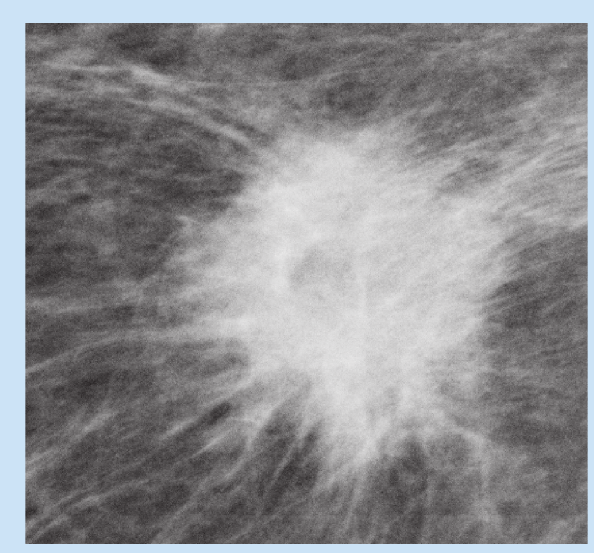
Fig. 3. Patient 3 – heterogeneous calcifications (with spiculated mass); calcification pattern is malignant.